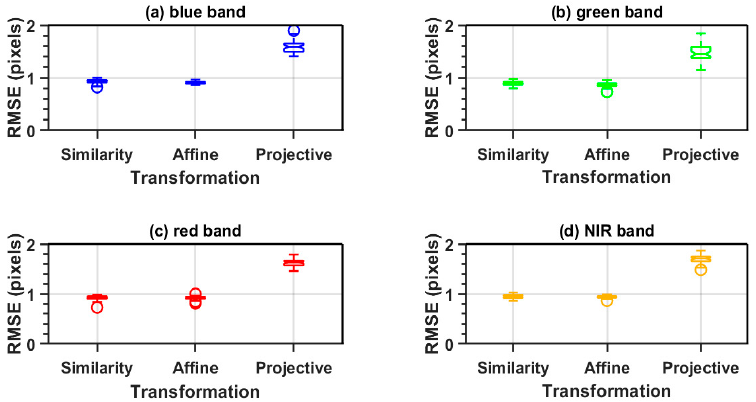
Figure 12. Variation of the root mean square error (RMSE in pixels) computed for the inliers matching points as a function of the geometric transformation that was used to transform the blue ( a ), green ( b ), red ( c ), and NIR ( d ) band moving image into the fixed (red-edge band) image space.